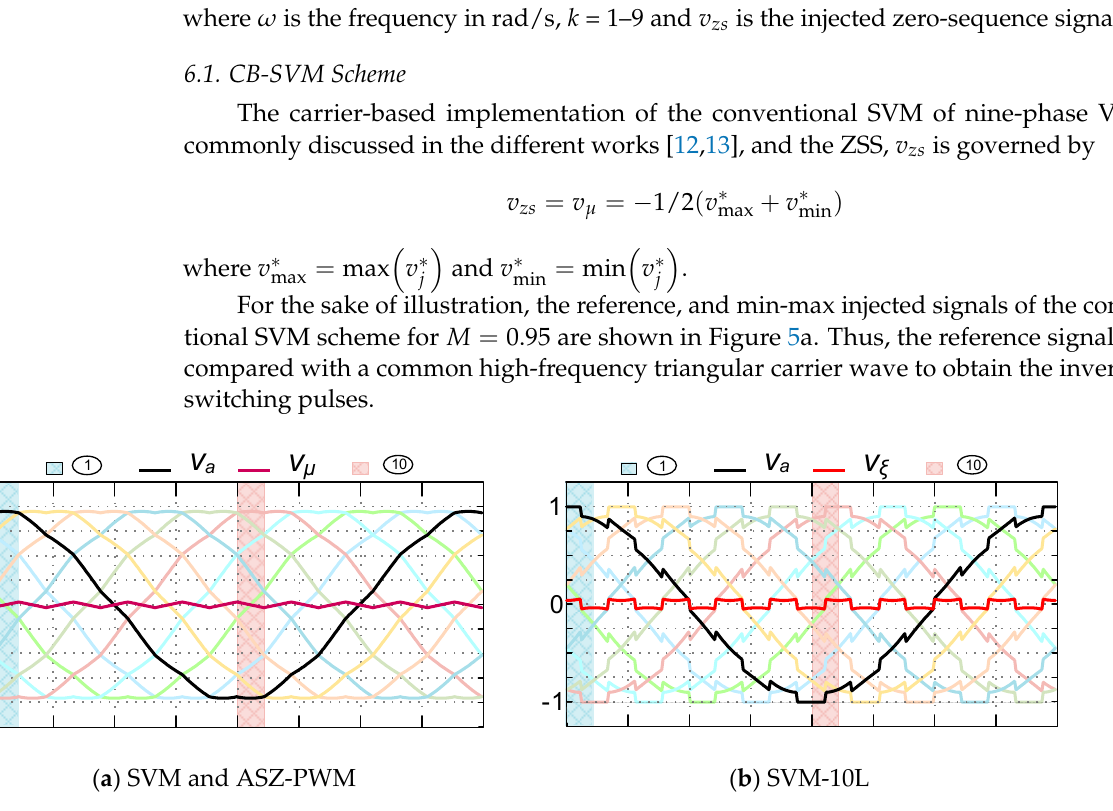
Figure 5. Reference and injected signals of carrier-based implementation. Conversely, in the CB implementation of CMVR schemes, two opposite carrier waves are utilized instead of a single carrier [13]. The carrier-wave selection depends on the sector or the phase order, as shown in Table